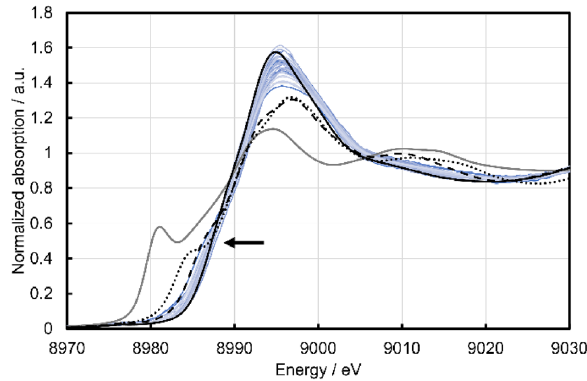
Figure 2. Cu K-edge XANES spectra of the twenty-eight Cu zeolites presented in Fig. 1 (blue), together with reference spectra for Cu 2 O (gray solid), Cu(OH) 2 (black dashed), CuO (black dotted) and Cu(NO 3 ) 2 aq (black solid). The arrow indicates the adsorption edge at 0.5 of the normalized absorption, where the edge energies are collected as a structural variable of the Cu zeolites.